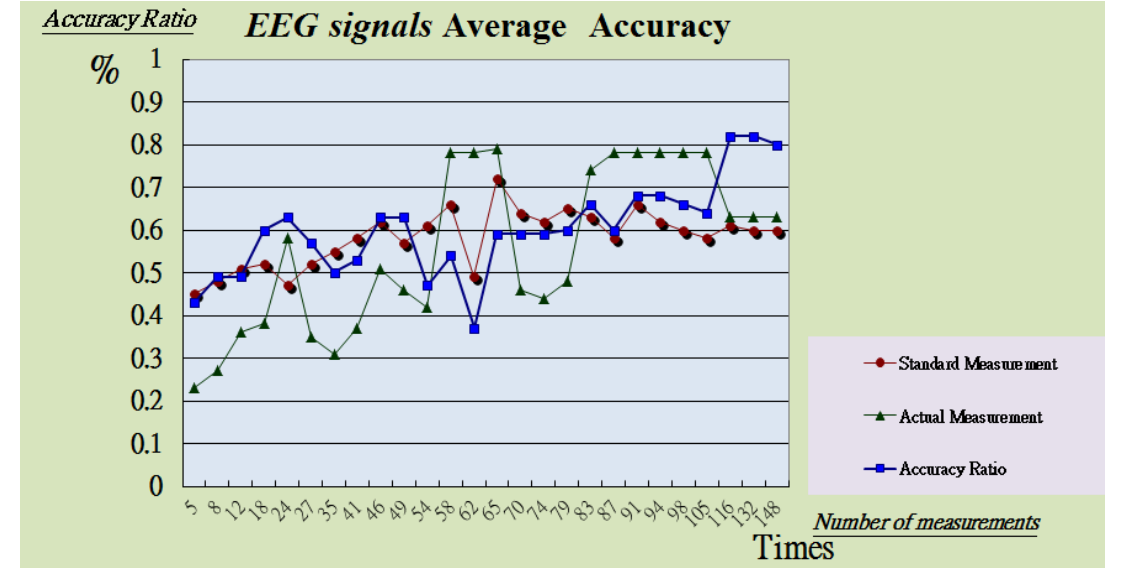
Figure 13. Average Accuracy of physiological